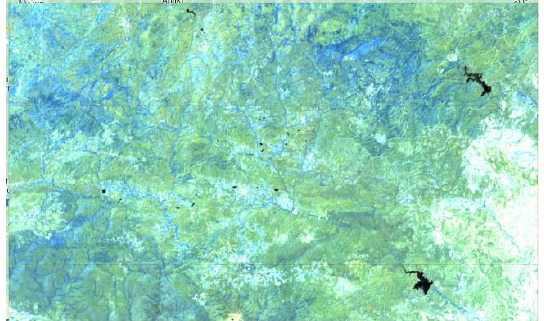
Figure 5 Histogram data plot for B12 before and after the fire event. The units on y-axes the frequency of the pixel values and the x-axis the pixel value of the reflectance scaled in